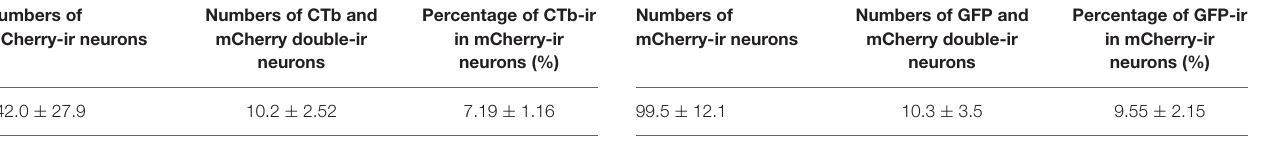
Frontiers in Neuroanatomy |